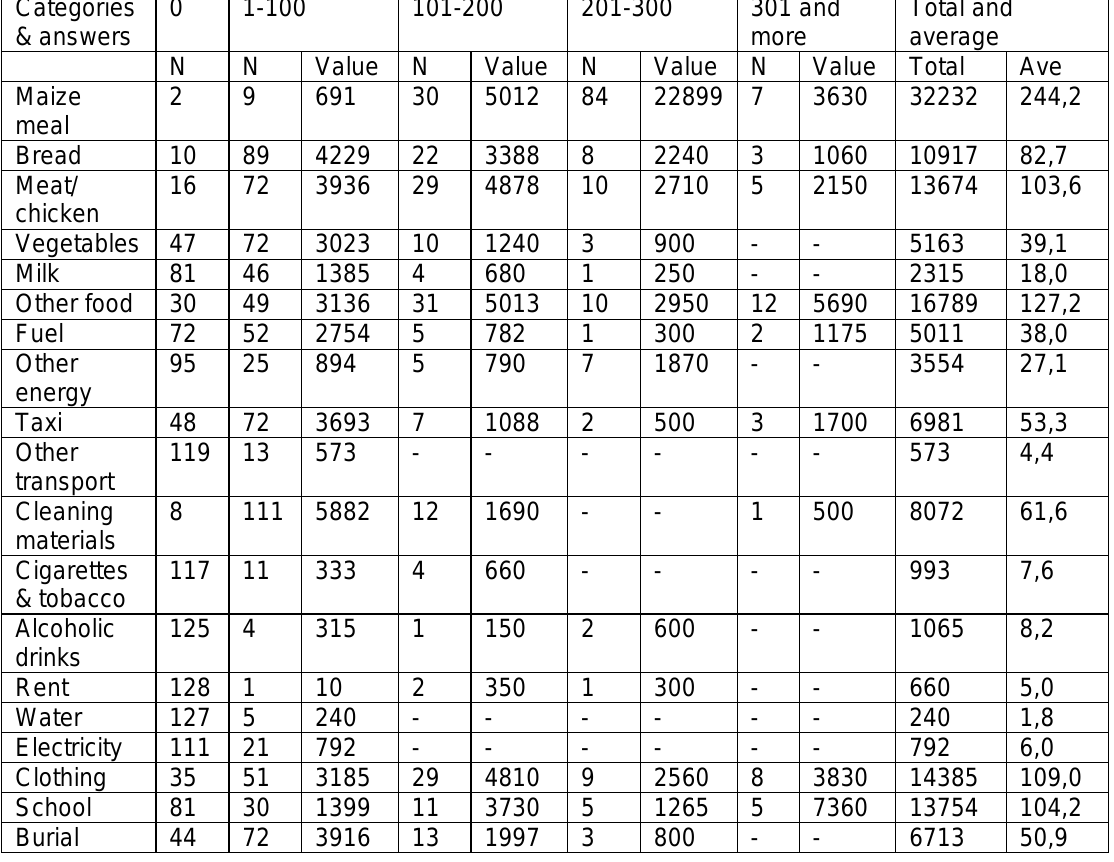
Table 1: Expenditure in selected rural households in 2007 (N=132), Rand values